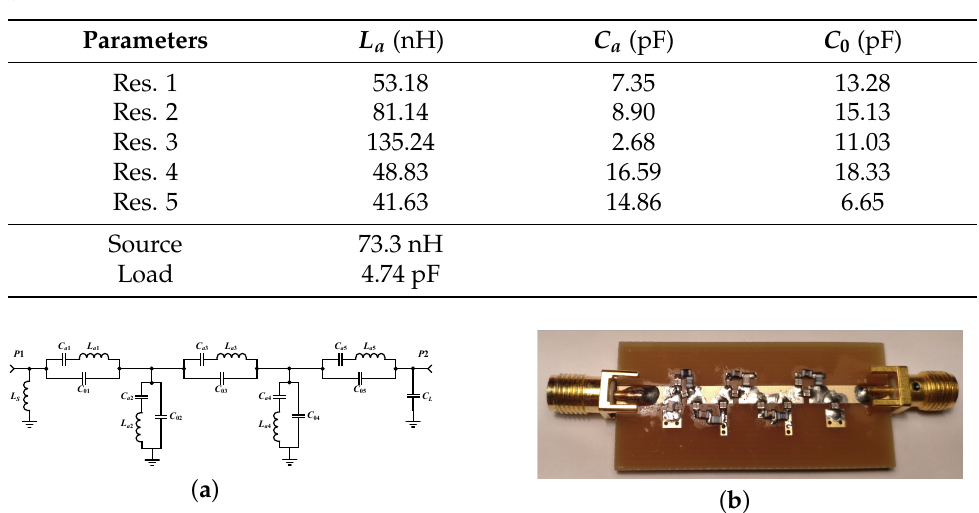
Table 9. Bandpass elements of the 5th-order ladder filter with phase correction terms φ = − 89.3 ◦ , ψ = − 27.7 ◦ .